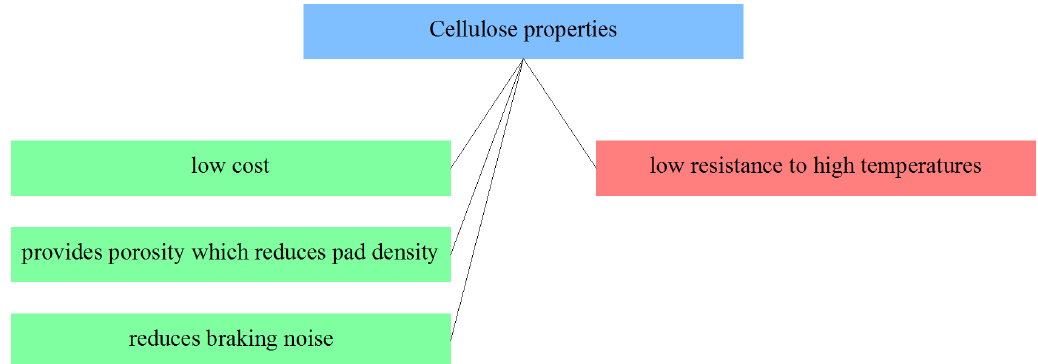
Figure 20: Selected cellulose composites properties from the point of view of applicability in friction